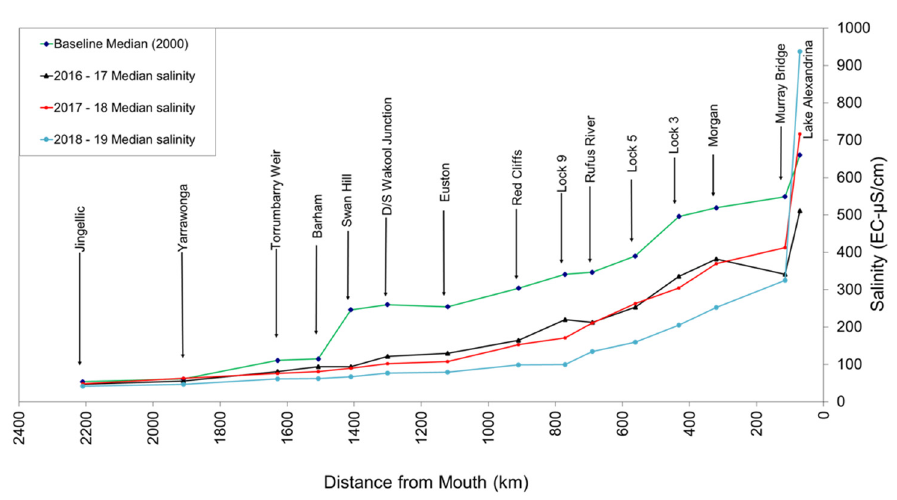
Figure 5. Daily salinity along the River Murray showing the reduction in salinity between the 2000 and 2016–2017, 2017–2018, and 2018–2019. (Source: MDBA). The major features of the first salinity strategy, which have underpinned subsequent salinity strategies, are summarized below.